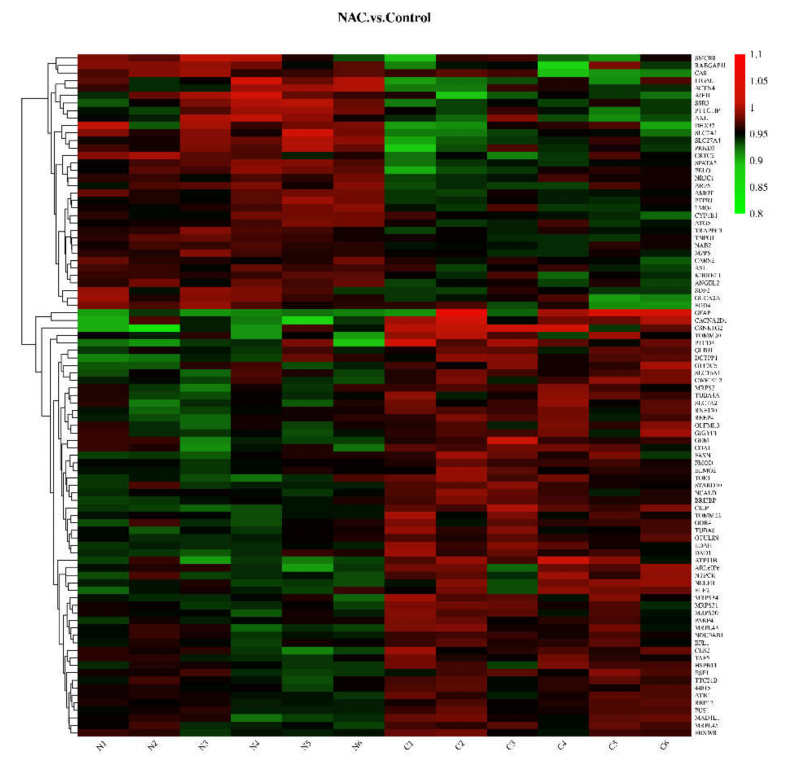
Figure 2. Clustering heatmap of differentially expressed proteins. N1, N2, N3, N4, N5, and N6, NAC group; C1, C2, C3, C4, C5, and C6, control